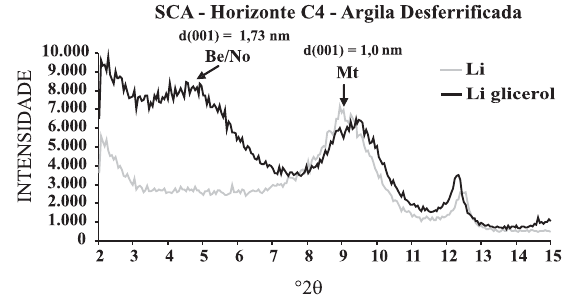
Figura 7. Difratogramas de raios X de amostras orientadas de argila desferrificada do horizonte C4 do perfil do Setor de Ciências Agrárias (SCA) da UFPR, submetidas ao teste de Greene-Kelly. Be - beidelita; Mt - montmorilonita; No -